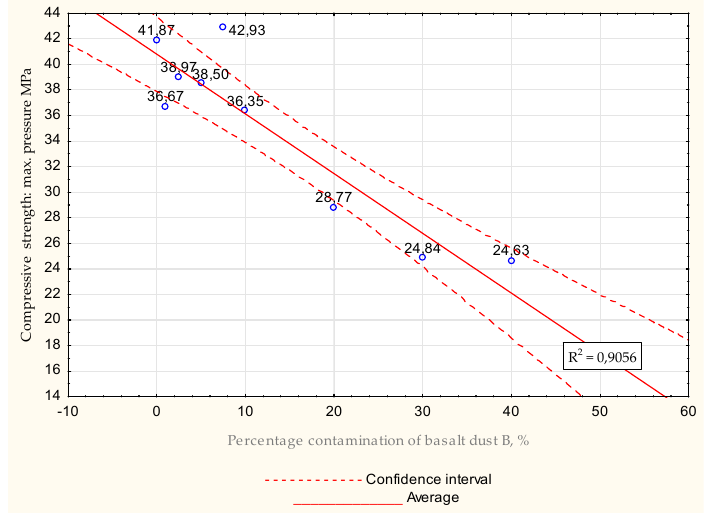
Figure 29. Average values obtained during compressive strength tests after 28 days for water − mix ratio = 0.5, max. strength.